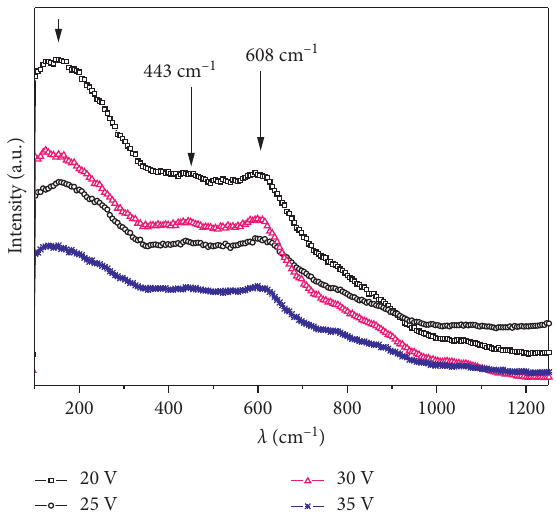
Figure 6: Raman spectra of different anodized samples at different voltages in H